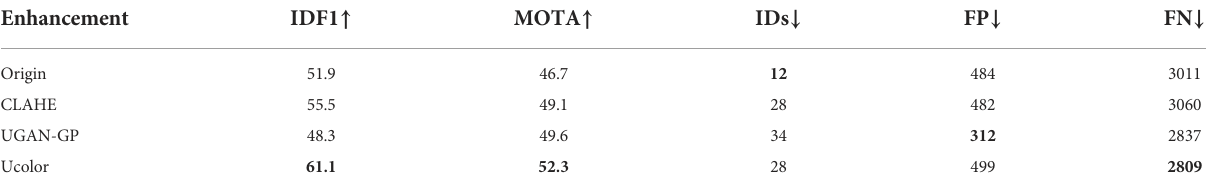
TABLE 5 Comparison of the different enhancement